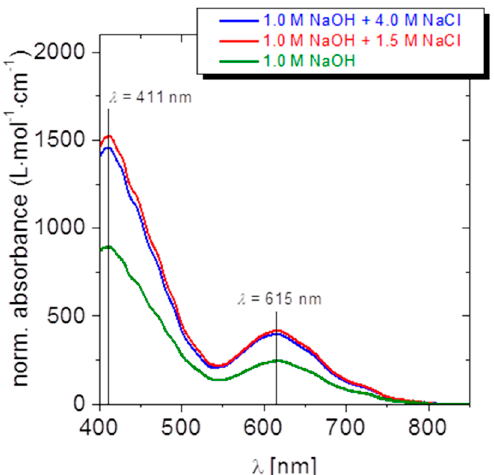
Figure 3. Normalized UV-vis spectra of the supernatant of solubility experiments with Na 2 Np 2 O 7 (cr) equilibrated in 1.0 M NaOH, 1.0 M NaOH + 1.5 M NaCl and 1.0 M NaOH + 4 M NaCl. Modified from [42].